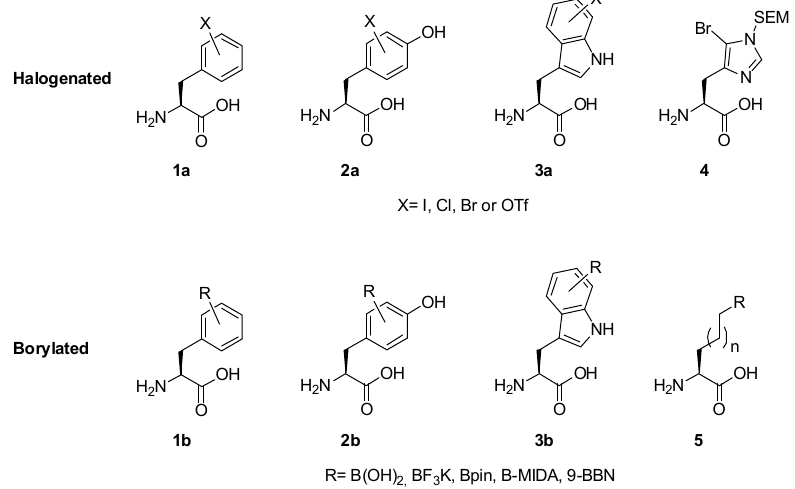
Figure 1. Representative examples of building blocks used in Suzuki–Miyaura-based derivatizations.